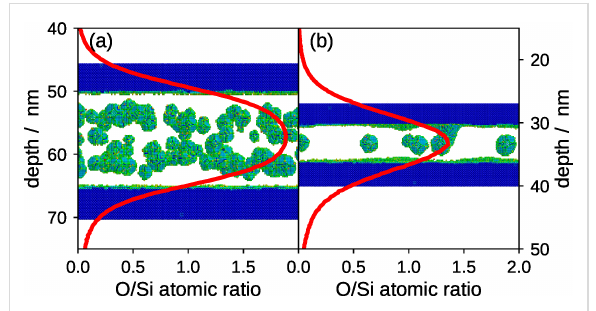
Figure 2: Computer simulation of broad-beam ion mixing and nano- cluster formation by thermal decomposition in Si/SiO 2 /Si layer stacks: binary collision approximation (BCA) method calculated O/Si atomic ratio profiles are plotted against the depth (red lines) and 3D